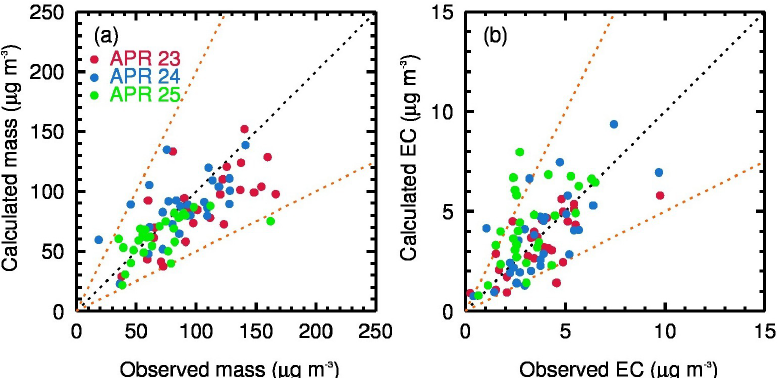
Figure 8. Comparisons between the predicted and measured daily (a) PM 2 . 5 and (b) elemental carbon mass concentrations at 29 sites from 23 to 25 April 2013. The 1:1, 1:2, and 2:1 lines are plotted as dotted